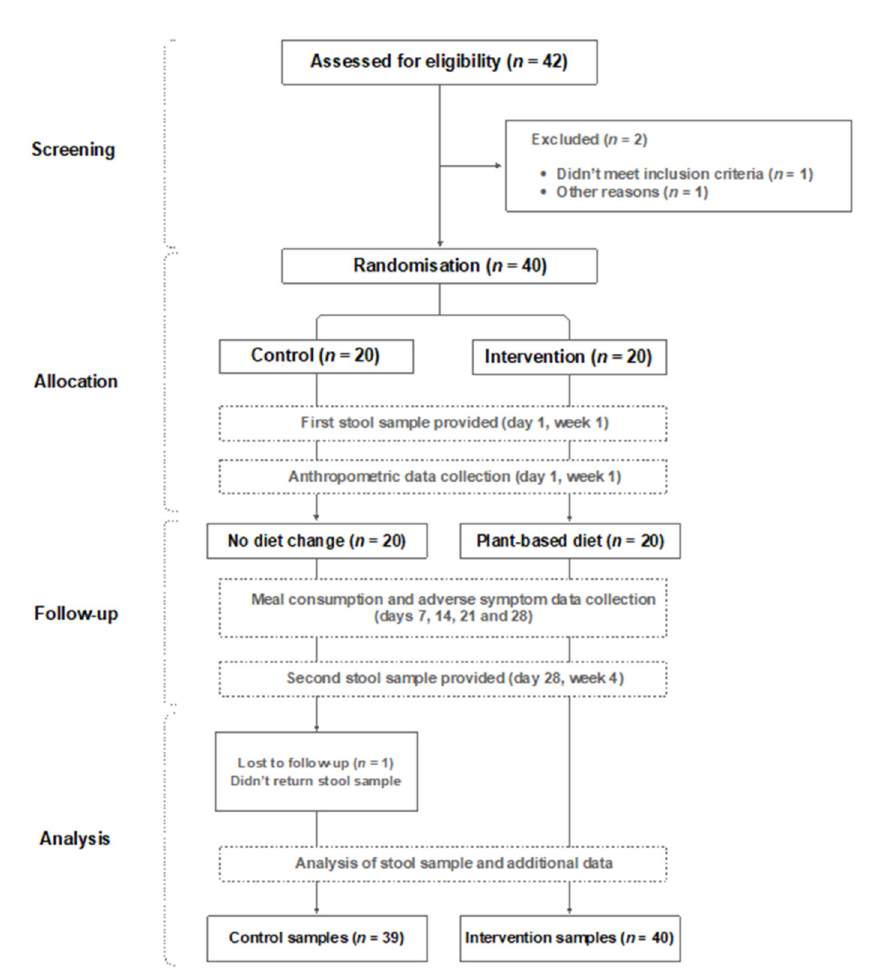
Figure 1. Study flow